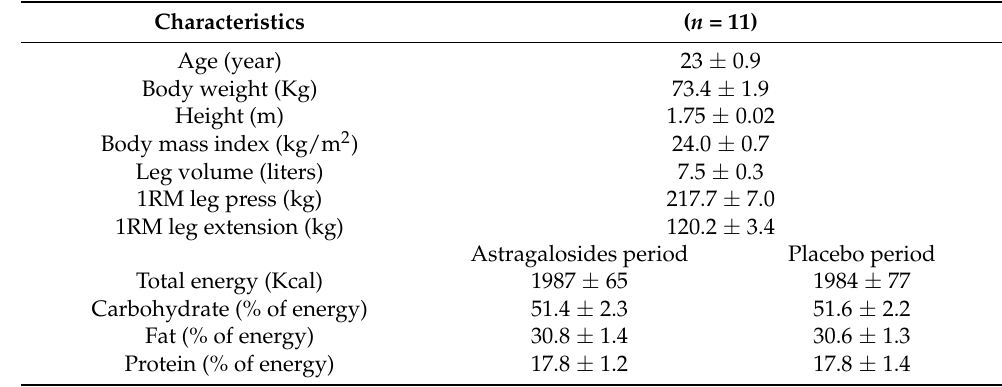
Table 1. Subjects’ Table 1. Subjects’ Characteristics.